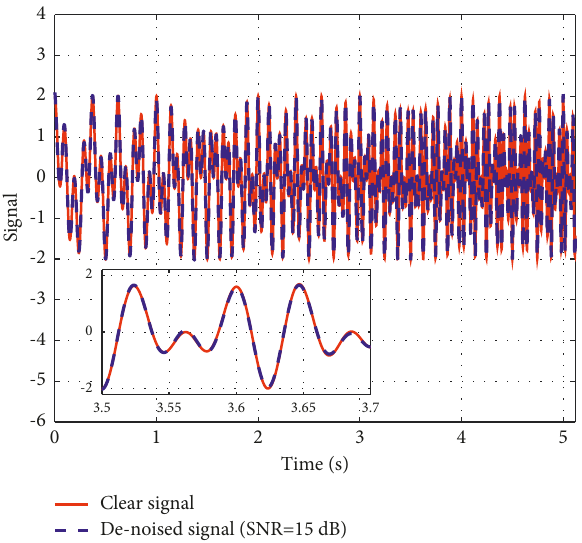
Figure 5: Noise elimination of non-stationary signal using pro- posed method when SNR � 15 dB.